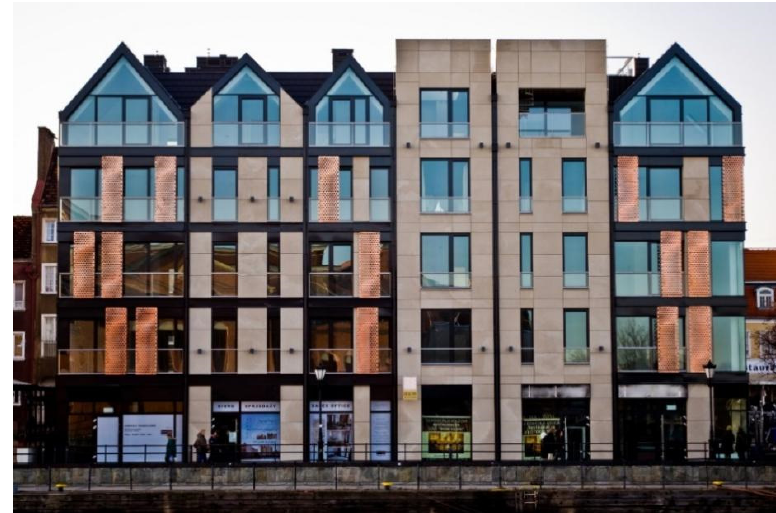
Figure 12. Tenement houses at Targ Rybny in Gda ń sk; designed by Kurylowicz &Associates [54].